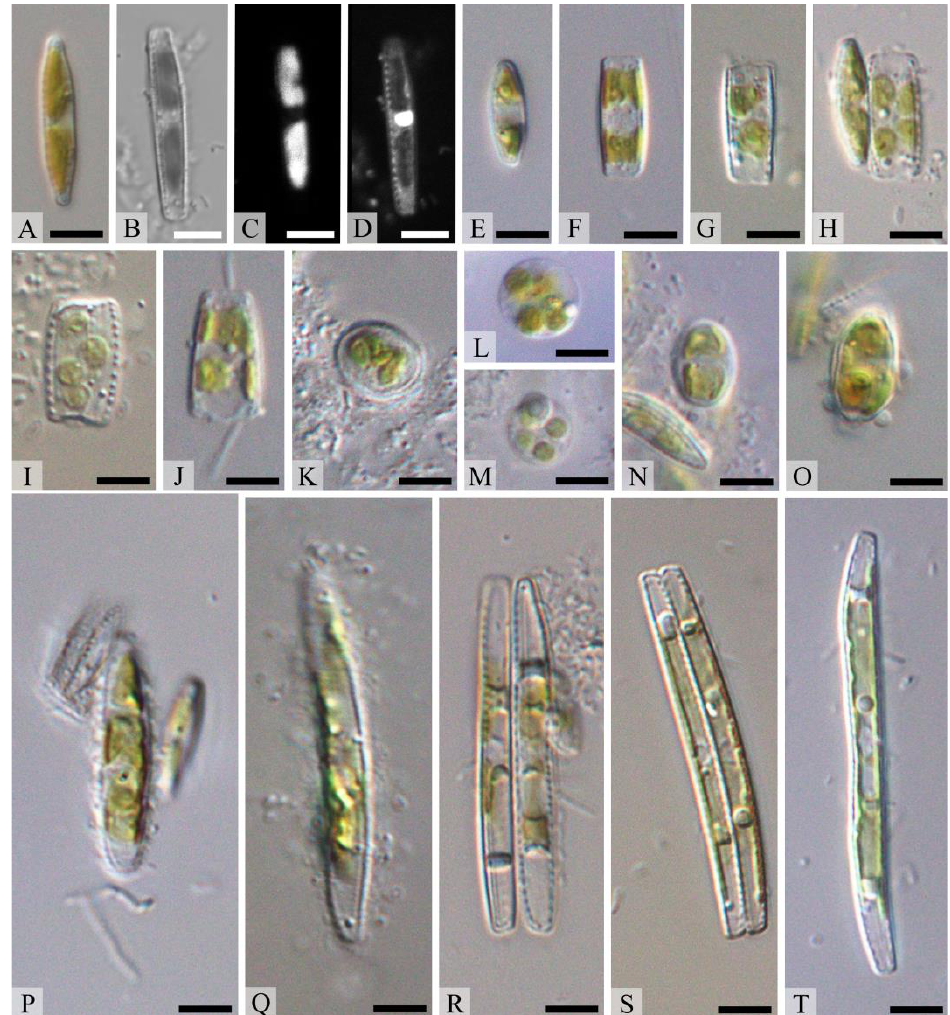
Figure 3. Life cycle of N. acidoclinata . ( A – D ) Vegetative cells, ( C ) nucleus, ( D ) chloroplasts, ( E ) cell before auxosporulation, ( F ) beginning of auxosporulation, ( G , H ) a cell with four chloroplasts, ( I ) contracted chloroplasts, ( J , K ) fusion of protoplasts (gametes) forming a zygote, ( K ) fusing of gam- etes forming a zygote, ( L , M ) abortion of a zygote, ( N , O ) auxospore germination from the zygote,